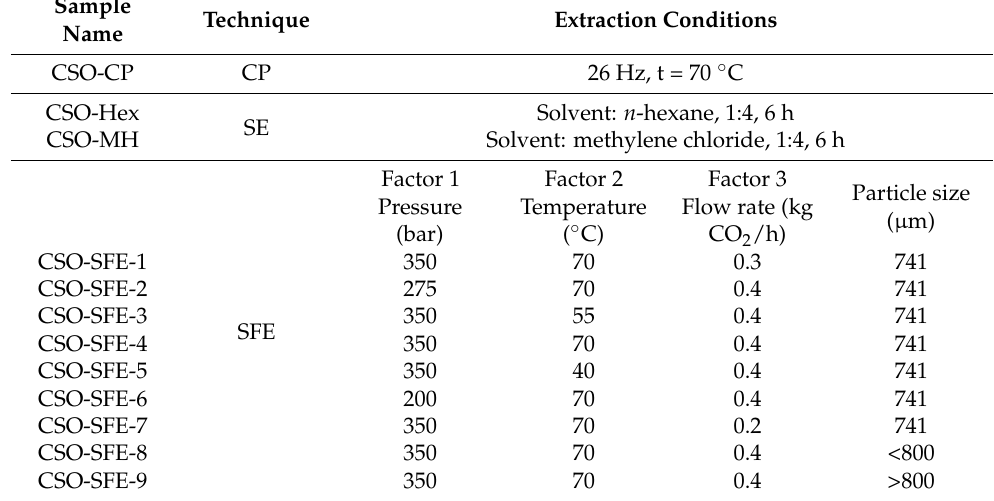
Table 1. Extraction techniques and process